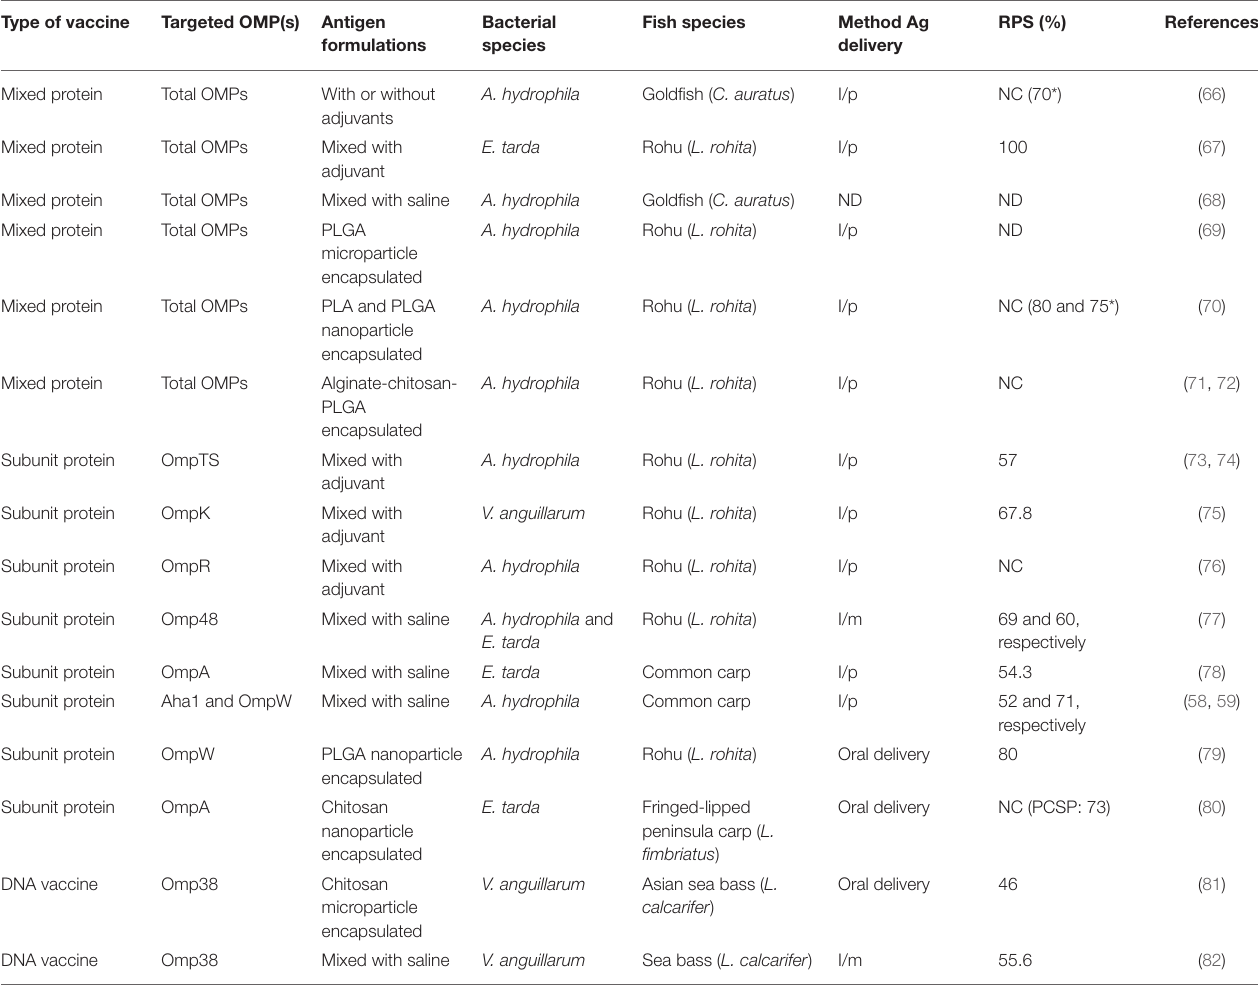
TABLE 2 | Outer membrane protein (OMP)-based vaccination studies conducted in India against major bacterial fish pathogens. Type of